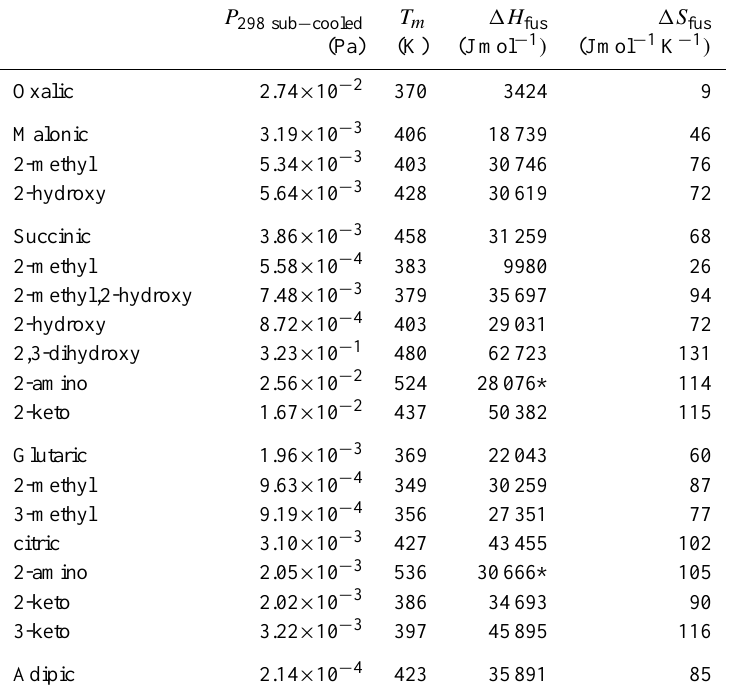
Table 4. Sub-cooled liquid vapour pressures, melting points, enthalpies and entropies of fusion. * denotes thermochemical data was unobtainable, Joback et al. (1987) estimates were used instead. Estimated maximum error on P 298 sub − cooled ± 75%.